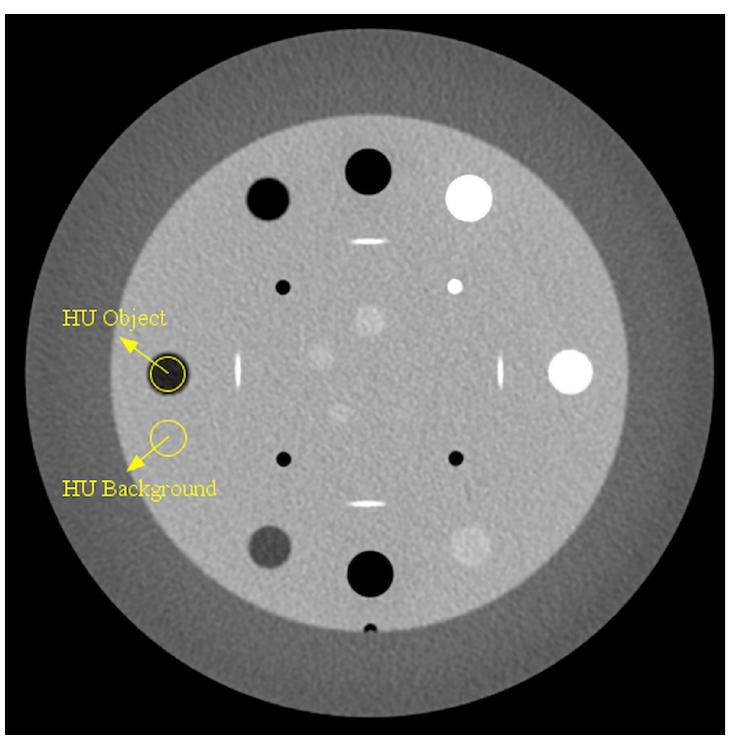
Fig 1. ROIs position for CNR evaluation in the CTP404 module of the Catphan-504 phantom. The depicted ROIs refer to the LDPE contrast insert.